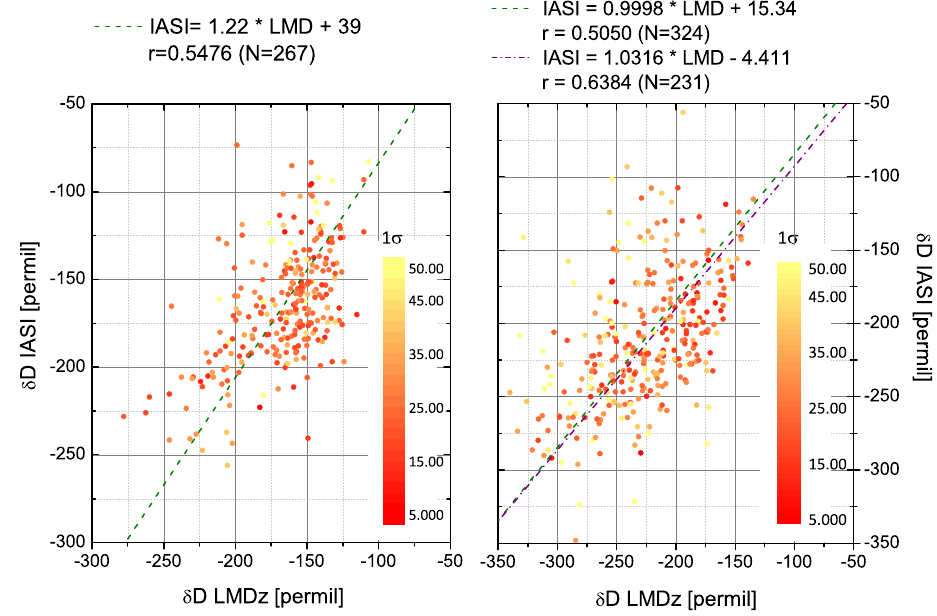
Fig. 10. Scatter plots of daily averaged δ D IASI observations versus LMDz-iso simulations for Iza˜na site (right) and Darwin site (left). The color scale indicates the daily variability (1 σ ) of IASI retrieved values in the model grid box. The dashed and the dashed-dotted lines are reduced major axis regressions on all points (dashed green lines) and, for Iza˜na, on points with a 1 σ variability in the model grid box lower than 35. In the case of Iza˜na, there is clear increase of the correlation coefficient (from 0.5 to 0.64) when considering only δ D averages with a certain variability threshold (averages with a daily variability inferior to 35‰, dashed-dotted violet line). The line equations, the correlation coefficient and the number of coincident values are given above the figures.